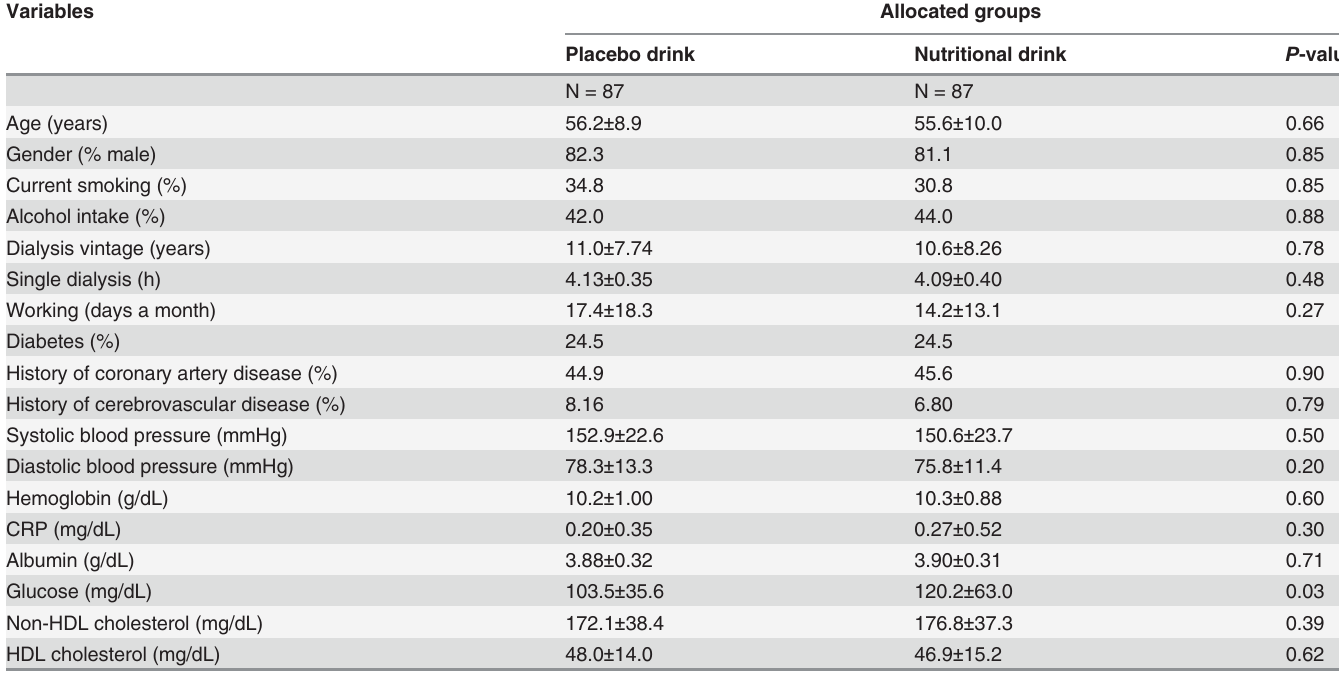
Table 1. Clinical characteristics of the study